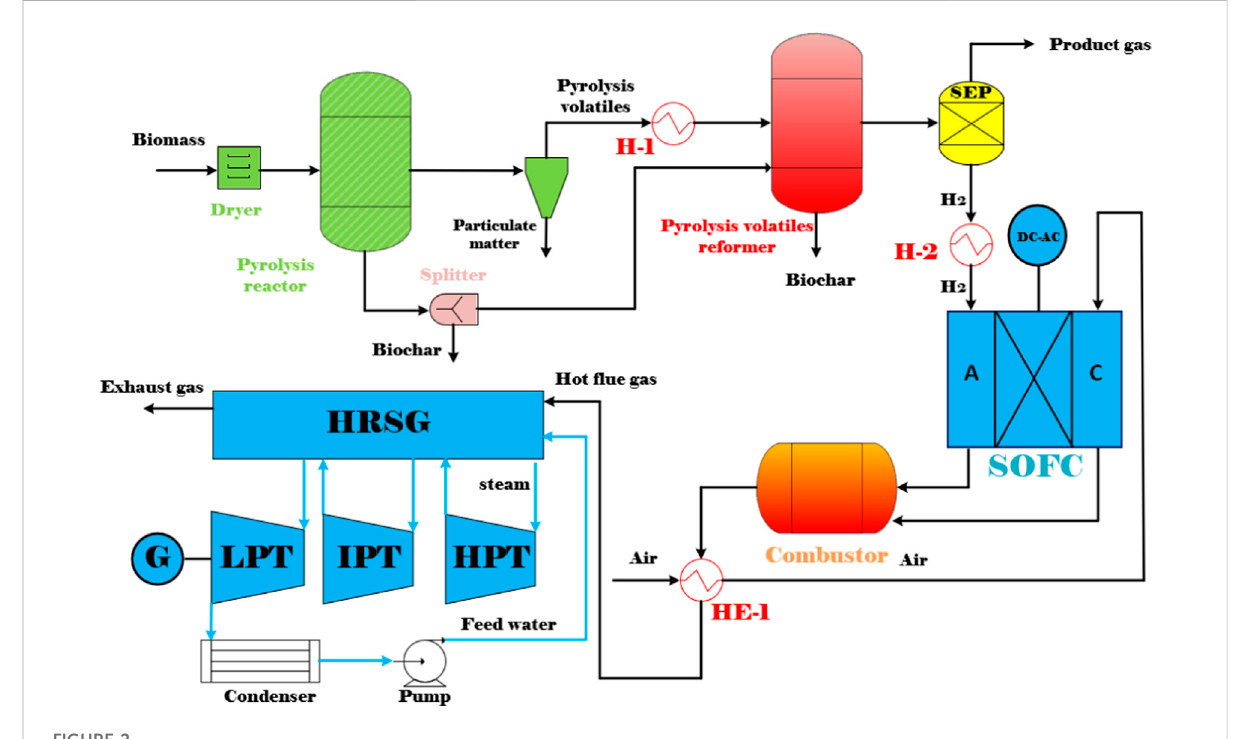
FIGURE 2 Process fl ow diagram of the BP-SOFC-CHP